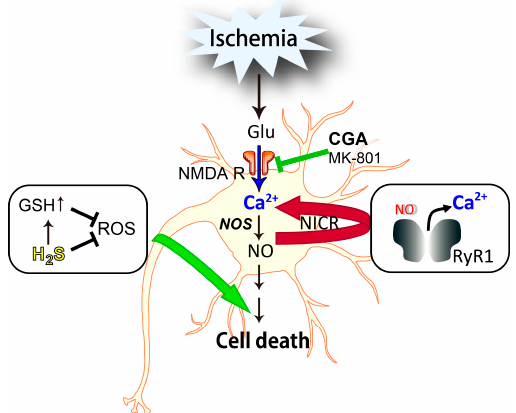
Figure 3. Effects of natural products and gaseous mediators on neuronal cell death. The N -methyl- D - aspartate receptor (NMDAR) is linked to downstream molecules, such as nitric oxide synthase (NOS). The activation of NOS leads to the production of nitric oxide (NO), which induces Ca 2+ release from the endoplasmic reticulum (ER) through S -nitrosylation of the type 1 ryanodine receptor (RyR1) and exacerbates neuronal cell death (red arrow). CGA inhibits NMDAR and subsequent influx of Ca 2+ into the neuronal cytosol (blue arrow), and prevents cell death. Hydrogen sulfide (H 2 S) protects neurons by increasing the levels of glutathione (GSH) and directly suppressing ROS in the mitochondria (green arrow). Abbreviations: Glu, glutamate; NICR, NO-induced Ca 2+ release; CGA, chlorogenic acid; ROS, reactive oxygen species.